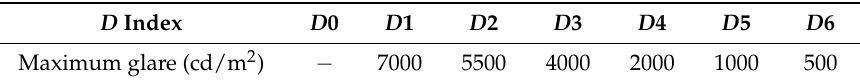
Table 1. “ D ” discomfort glare